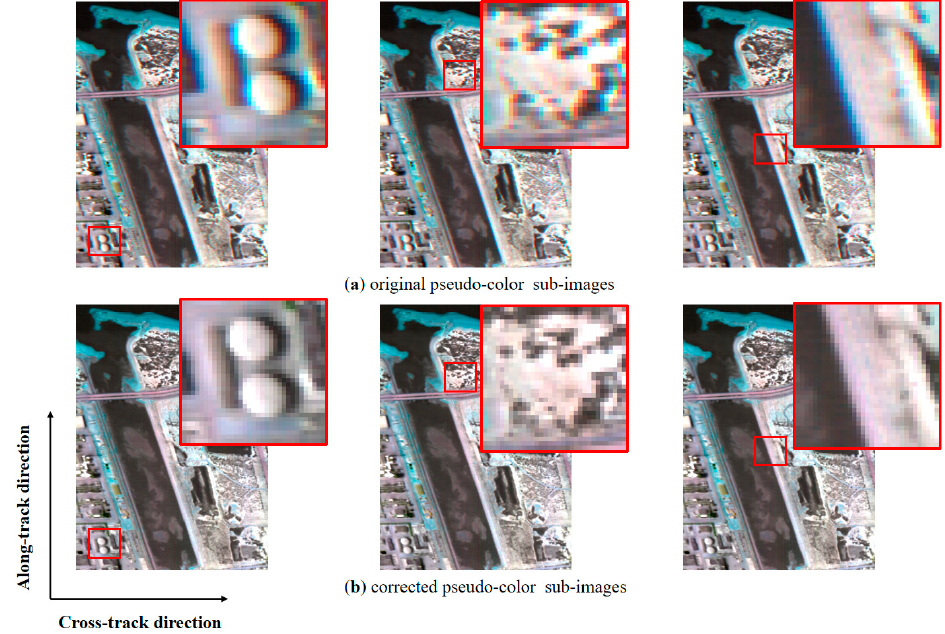
Figure 13. Comparison between ( a ) original sub-images and ( b ) corrected sub-images of buildings, plants, and seaside areas.